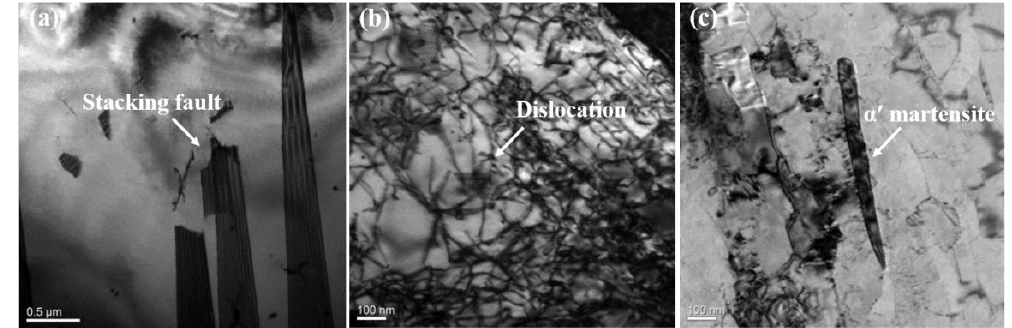
Figure 5. Transmission electron microscope (TEM) microstructures of solution-treated specimen ( a ) and the one subjected to two thermomechanical cycles ( b,c ).